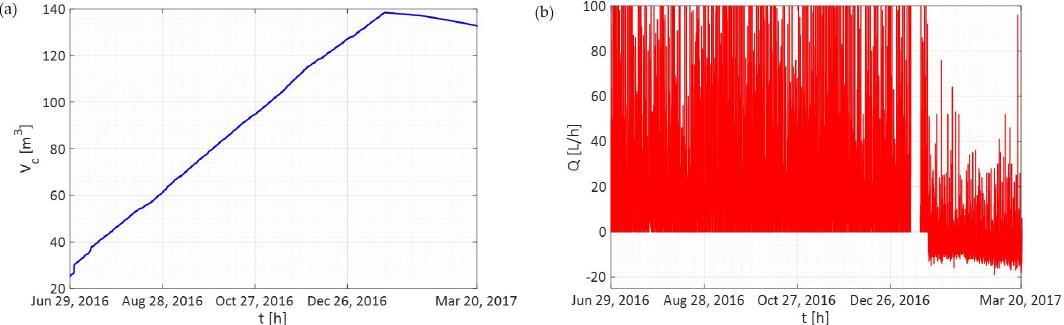
Figure 11. Totalized consumption trend measured by a faulty smart meter ( a ) and incremental consumption trend reported by the Cloud platform ( b